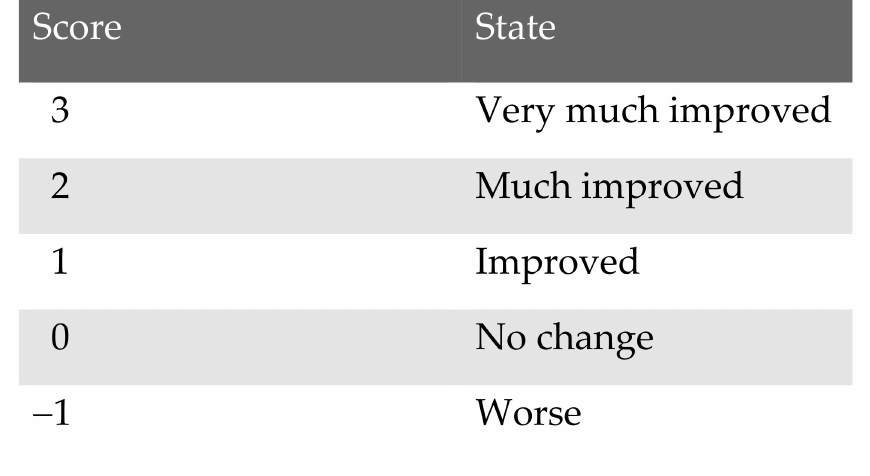
Figure 4. Patient’s satisfaction measured by global aesthetic improvement scale